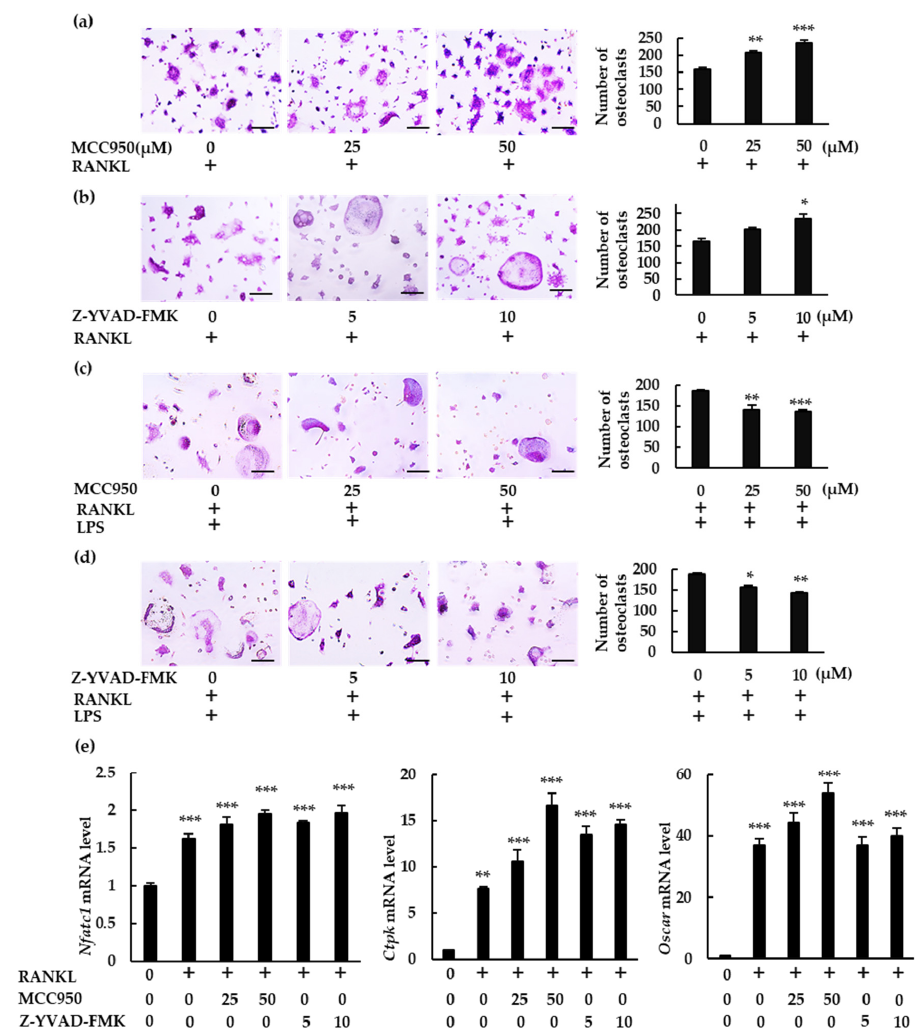
Figure 3. Differential effects of NLRP3 inflammasome inhibitors on osteoclast formation. ( a , b ) BMMs were treated with M-CSF (30 ng/mL) and RANKL (10 ng/mL) for 72 h in the presence of the indicated concentrations of MCC950 (an NLRP3 inhibitor) or Z-YVAD-FMK (a caspase-1 inhibitor). ( c , d ) BMMs were treated with RANKL (5 ng/mL) and M-CSF (30 ng/mL) for 48 h, then treated with LPS (10 ng/mL) and the same concentrations of M-CSF and RANKL for an additional 48 h in the presence of the indicated concentrations of MCC950 or Z-YVAD-FMK. Cells were subjected to TRAP staining, and TRAP-positive cells with three or more nuclei were counted as osteoclasts. ( e ) BMMs were treated with RANKL (0 or 20 ng/mL) and M-CSF (30 ng/mL) in the presence or absence of MCC950 or Z-YVAD-FMK for 60 h. Total RNA was extracted from cells and the relative expres- sion of Nfatc1 , CtpK , and Oscar mRNA was determined using qRT-PCR. Scale bars: 150 μ m. Results are expressed as the means ± SE of triplicate assays and the images are representative of three inde- pendent experiments. * p < 0.05, ** p < 0.01, *** p < 0.001 compared with the control. To confirm the role of NLRP3 inflammasome inhibitors, we performed a pit assay of RANKL-mediated osteoclastogenesis. RANKL-treated BMMs showed only mild